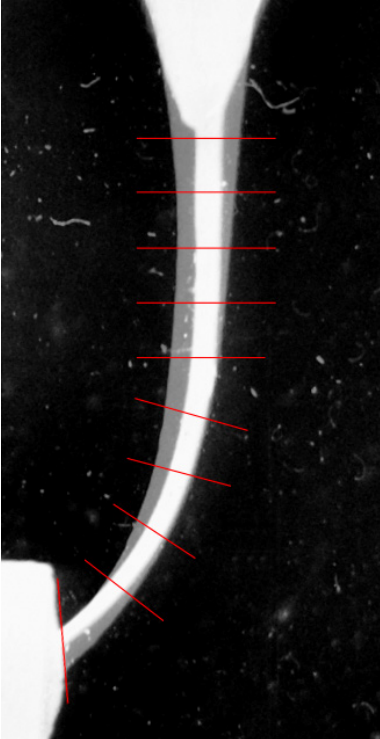
Figure 1. ( A ) preoperative image; ( B ) postoperative image with color-shifted image processing; ( C ) preoperative–postoperative composite image; and ( D ) grayscale image.